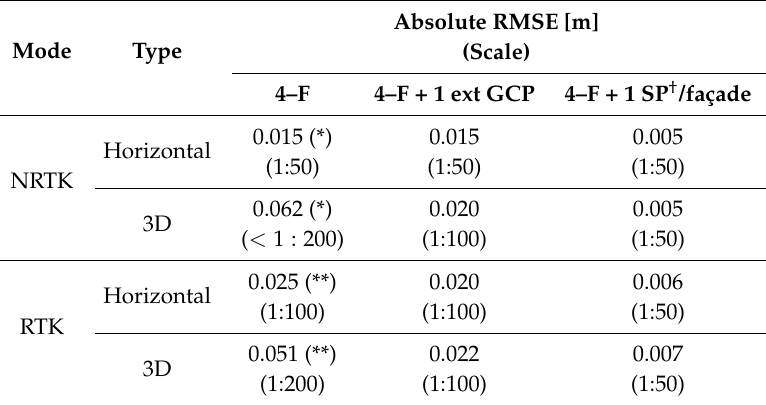
Table 9. Absolute RMSE for different bias-fixing strategies. The scale whose metric survey specifications were satisfied is also reported in